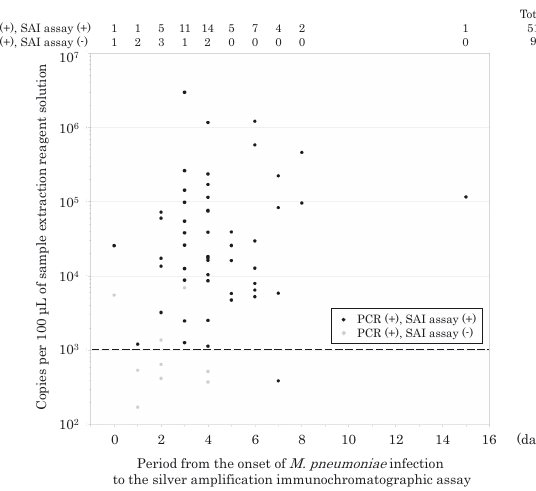
Figure 3: Relationship between copy numbers of M. pneumoniae per100 μ Lofsampleextractionreagentsolutionandperiodfromthe onset of M. pneumoniae infection to the SAI assay. Black dots represent real-time PCR-positive and SAI assay-positive samples, and gray dots represent real-time PCR-positive and SAI assay-negative samples. The dotted line shows the level of 1 × 10 3 copies per 100 μ L of sample extraction reagent